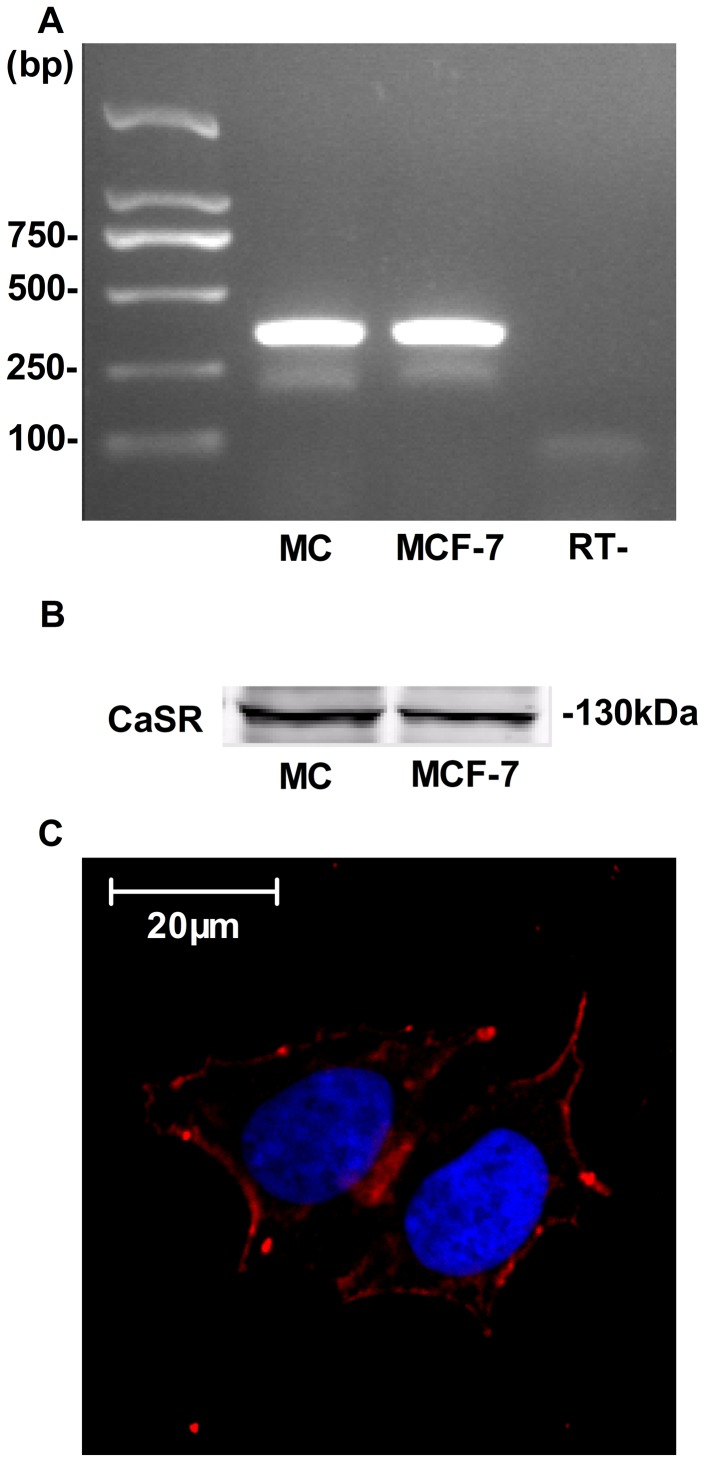
Expression of CaSR mRNA and protein in human MCs.(A) RT-PCR was performed on total RNA extracted from human MCs or MCF-7 cells (a human breast cancer cell line used as a positive control) using primers specific for the human CaSR to detect CaSR mRNA expression. A PCR product of the expected size (424 bp) was observed. In the absence of reverse transcriptase (RT-), no PCR-amplified products were detected. (B) Western blot analysis was performed to detect the protein expression of CaSR in human MCs. A 130 kDa band was found in both human MCs and in the positive control of MCF-7 cells. (C) Immunofluorescence detection of CaSR localization in human MCs with anti-CaSR antibody. Red color indicates labeling with CaSR, and blue color shows DAPI-stained nuclei. Scale bar, 20 µm. At least 50 cells were examined, and the present images represent typical staining pattern for the majority of examined cells.